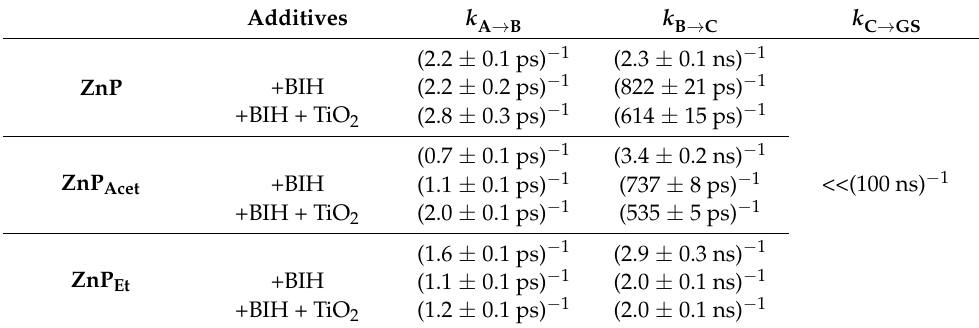
Figure 4. EAS (left) and representative decay profiles (right) of ( a ) ZnPs , ( b ) ZnPs + BIH, and ( c ) ZnPs + BIH + TiO 2 in DMF obtained from the global fits to the TA data. The first-order kinetic model (A → B → C → ground state (GS)) was used in the fit. The EAS data near 435 nm were omitted in ( b , c ) due to the scattered pump light. The solid lines in the decay profiles are the fits. Table 2. Kinetic Parameters from the Global Fits of the TA Spectra of ZnPs .